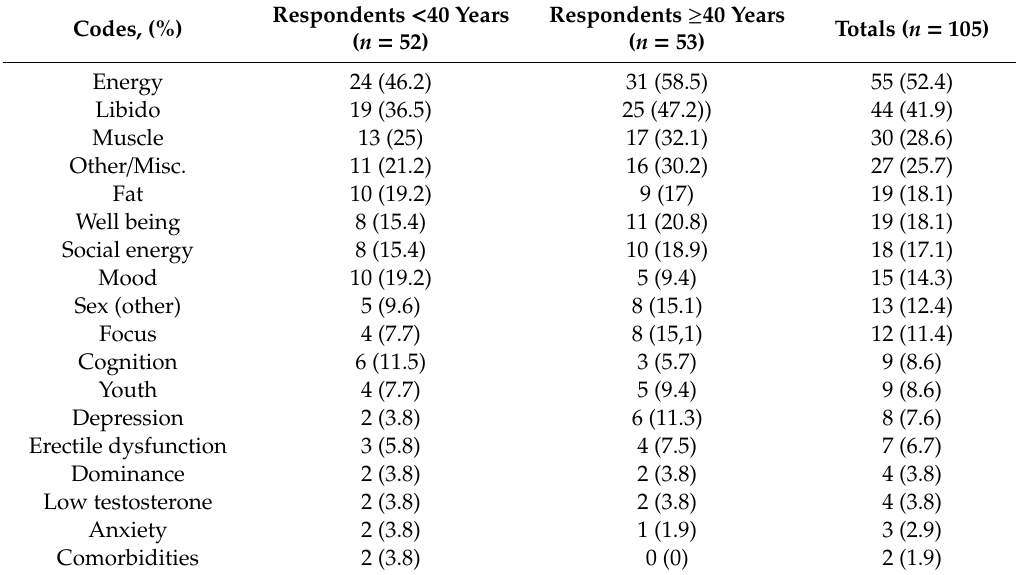
Table 5. Frequency of coding themes related to beneficial e ff ects noticed after